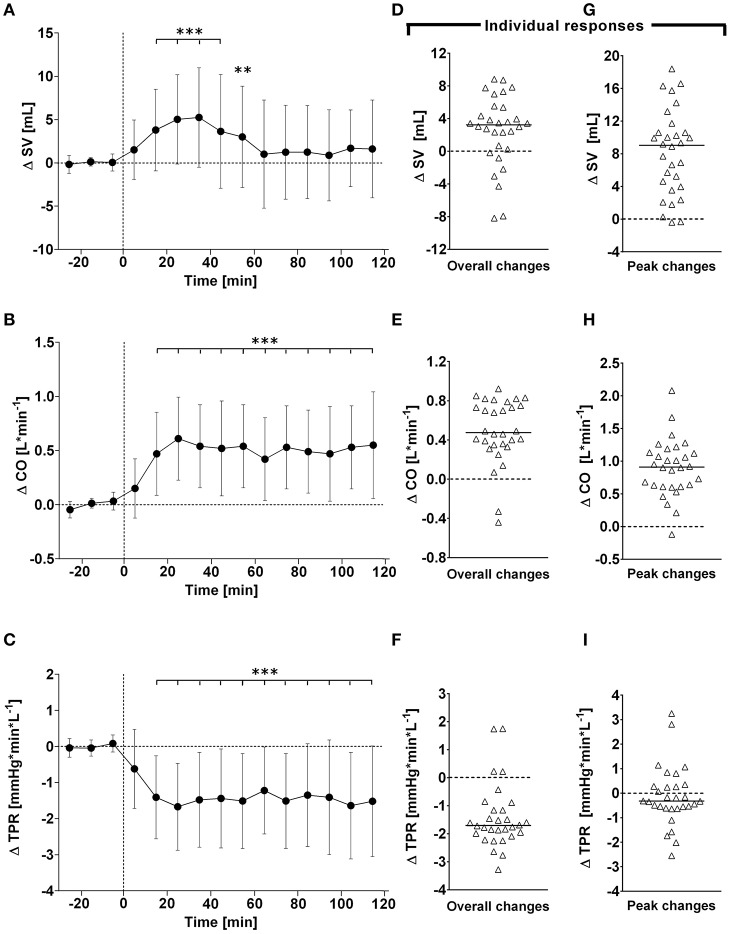
(A–C): Time course of changes (Δ) from baseline in stroke volume (SV), cardiac output (CO) and total peripheral resistance (TPR), respectively. Closed circles (•) represent averaged beat-to-beat data over 10 min intervals, which were subtracted from each baseline level and presented as deltas. Data recorded during the 4 min glucose ingestion period were excluded from the analysis, and Time 0 denotes the resumption of continuous cardiovascular measurements after subjects have finished the oral glucose drink. (D–F) represent overall (i.e., averages over 120 min with baseline values subtracted) changes in SV, CO, and TPR relative to baseline. (G–I) represent peak (i.e., derived from the maximum response averaged over a 10 min interval) changes in SV, CO, and TPR relative to baseline. **P < 0.01 and ***P < 0.005 represent statistically significant differences over time from baseline values (left). Left values are reported as means ± SD, whilst right data are presented as a scatter dot plot with a median (bold horizontal dashed line).